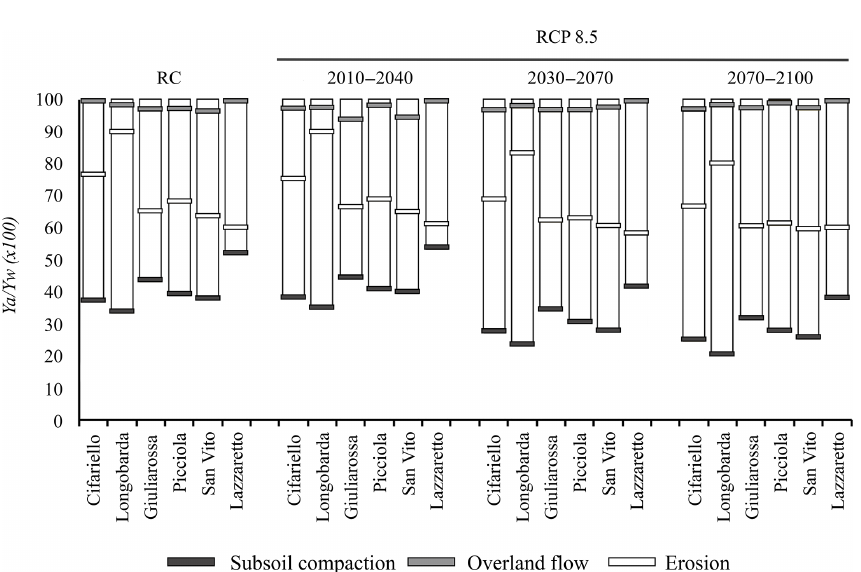
Figure 7. Range of soil physical quality indexes (Ya / Yw) × 100 for all the soil series, expressing the effects of different forms of soil degra- dation and climate change. The vertical bars for each type of soil (the genoform) represent a “thermometer” indicating a characteristic range of values obtained by establishing a series of phenoforms, represented by their Yw values. Soil quality for a given soil is thus represented by a characteristic range of values. Soil health is indicated by the particular location of an actual Ya within this